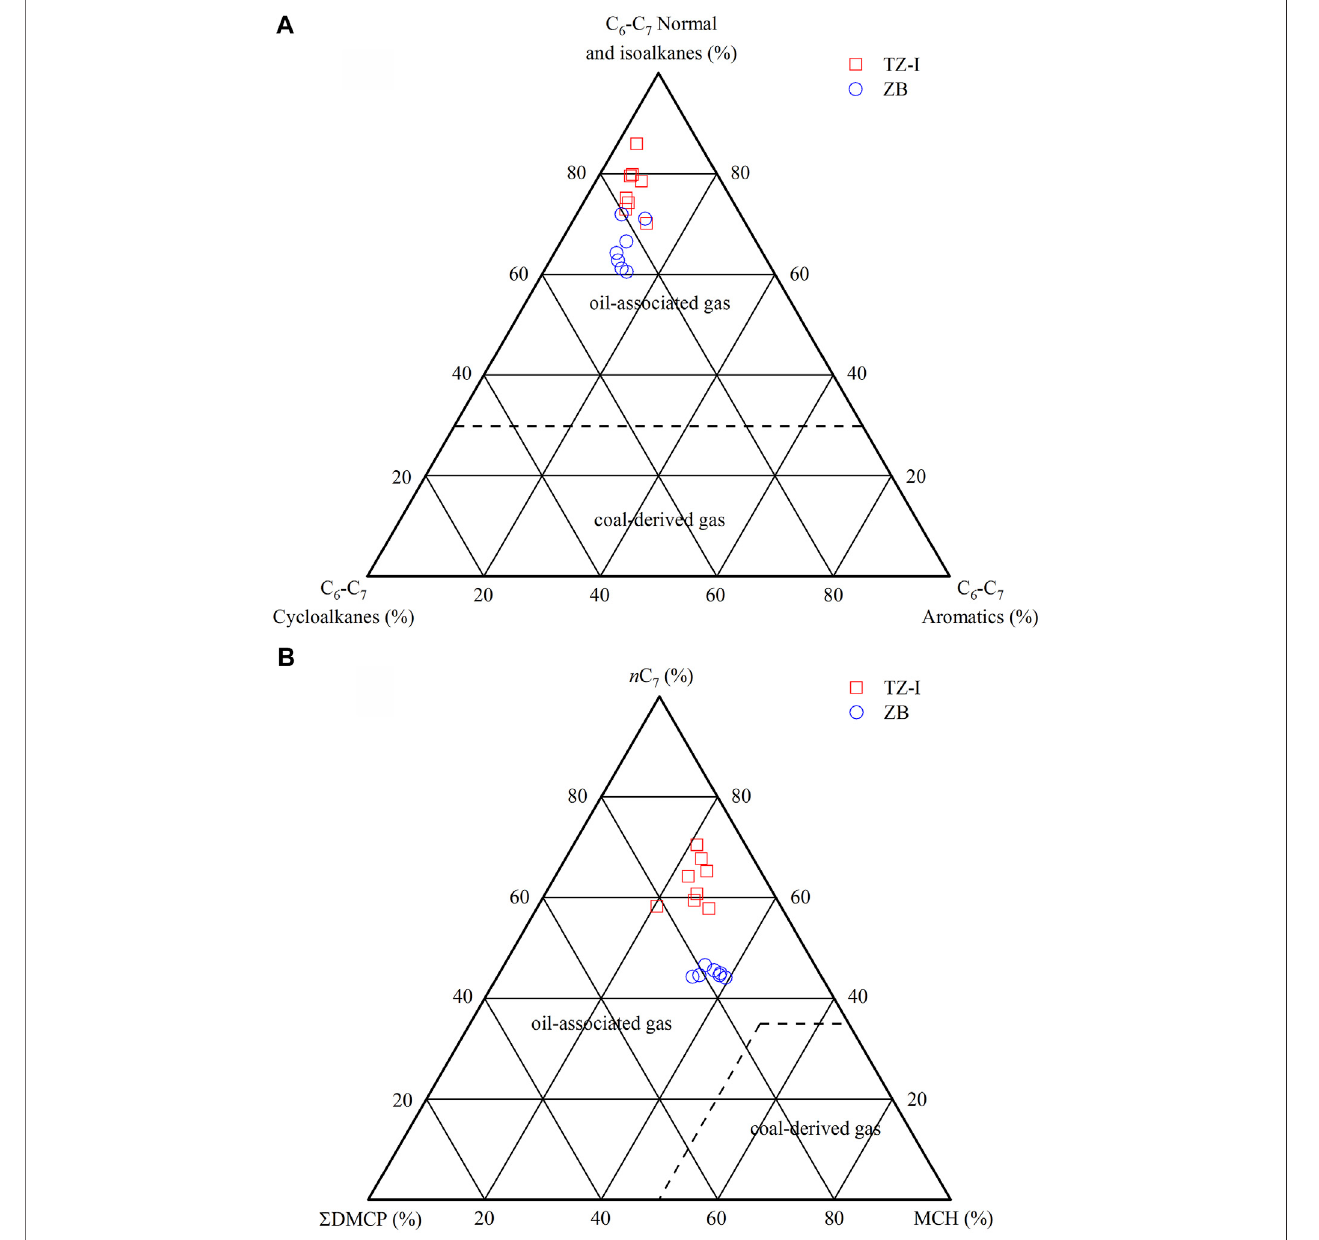
FIGURE 6 | Ternary diagram of C 6 – C 7 normal and isoalkane, cycloalkane, aromatic (A) and ternary diagram of n C 7 , DMCP and MCH (B) in the TZ-I and ZB gas fi elds (modi fi ed from Hu et al., 2008).